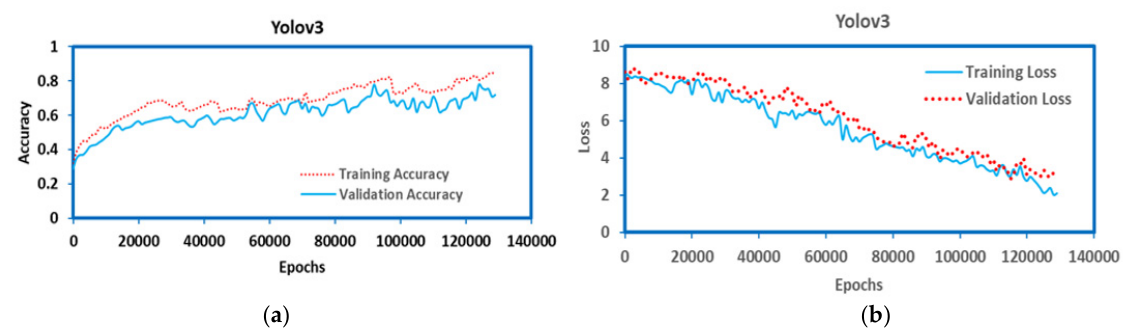
Figure 5. Training and validation process of modified YOLOv3. ( a ) The curve of Accuracy. ( b ) The curve of Loss.